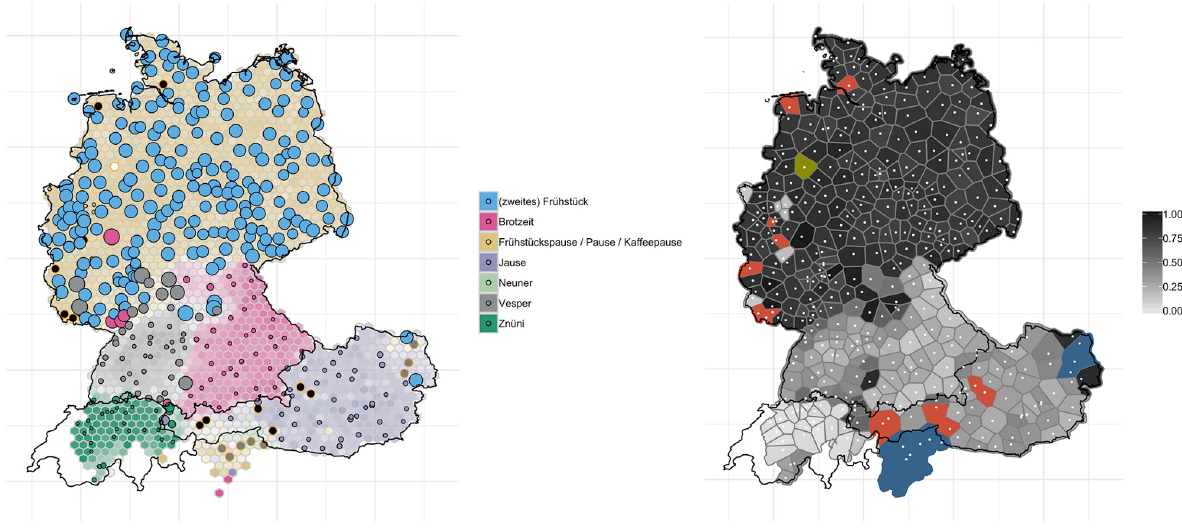
Fig 8. Variant and degree of change maps for ‘(second) breakfast that people have at their workplace’.